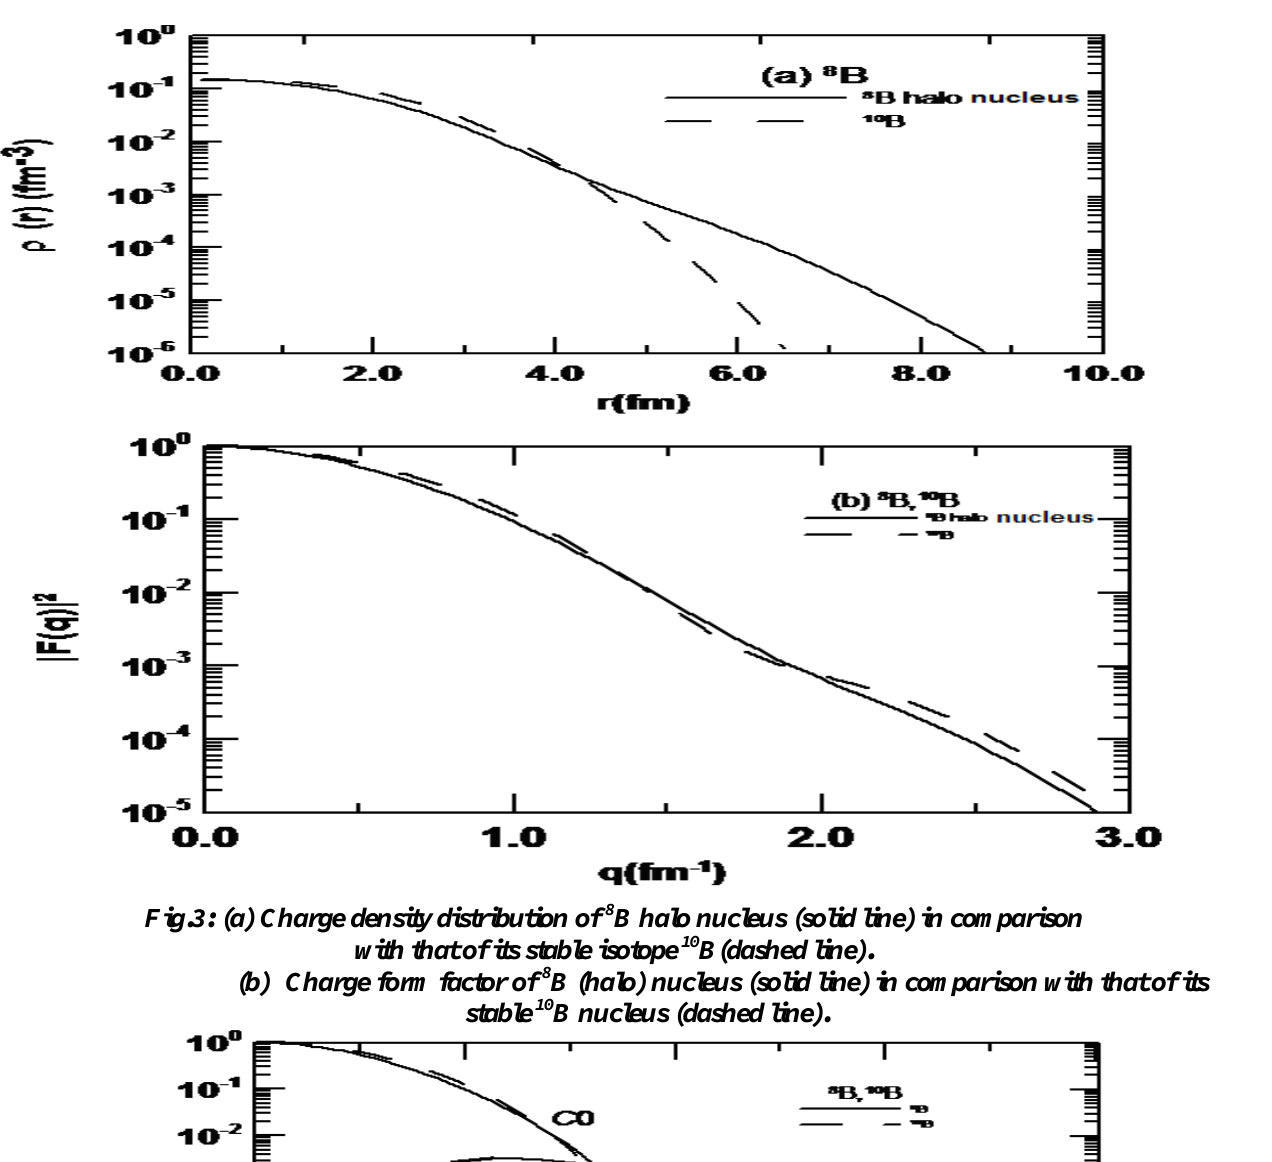
Fig.3: (a) Charge density distribution of 8 B halo nucleus (solid line) in comparison with that of its stable isotope 10 B(dashed line). (b) Charge form factor of 8 B (halo) nucleus (solid line) in comparison with that of its stable 10 B nucleus (dashed line).